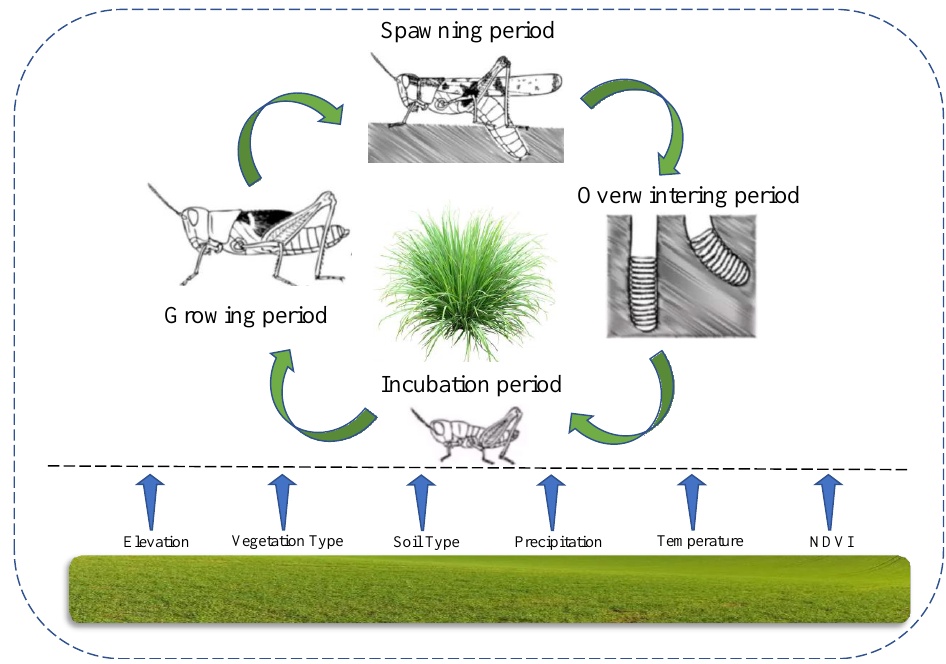
Figure 1. The environmental factors and reproductive periods of O. d. asiaticus .